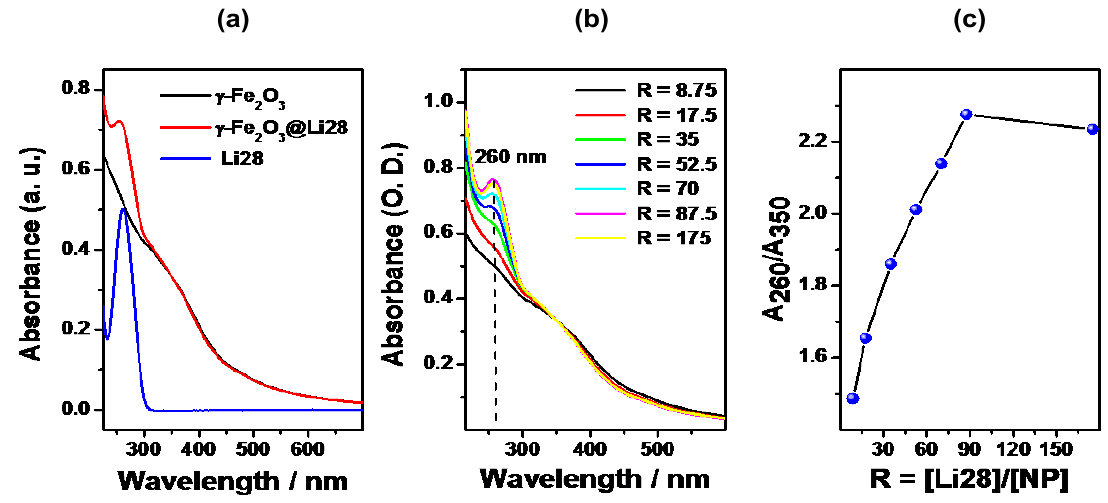
Figure 4. UV-Visible spectra of ( a ) uncoated NP at pH = 2, ODN and